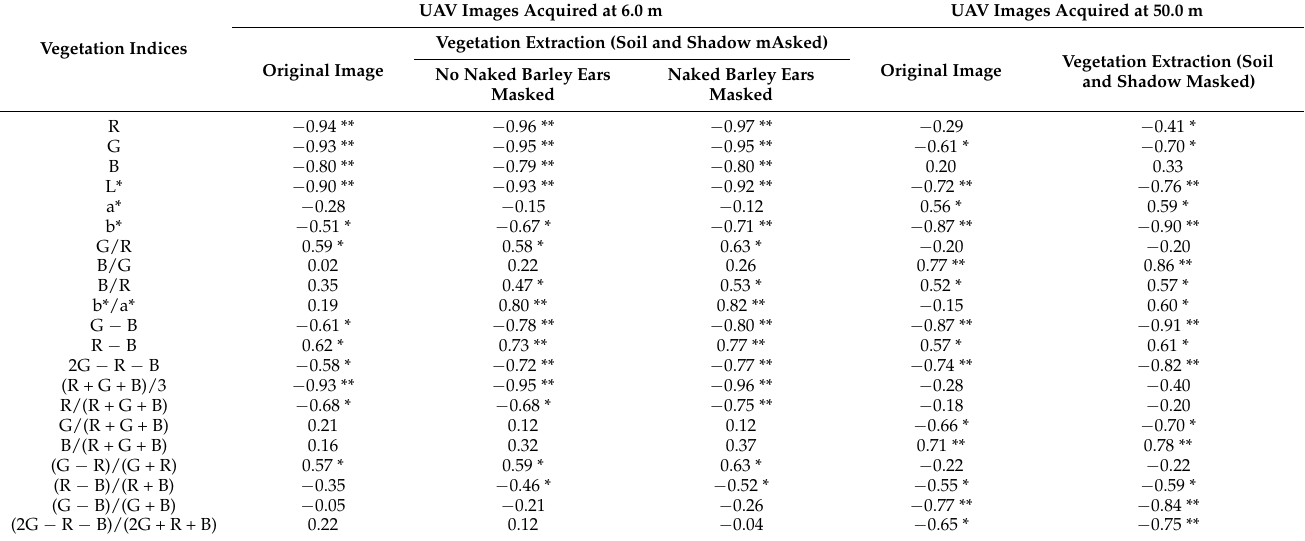
Table 4. Correlation coefficients between SPAD values and vegetation indices derived from UAV images. UAV Images Acquired at 6.0 Vegetation Indices